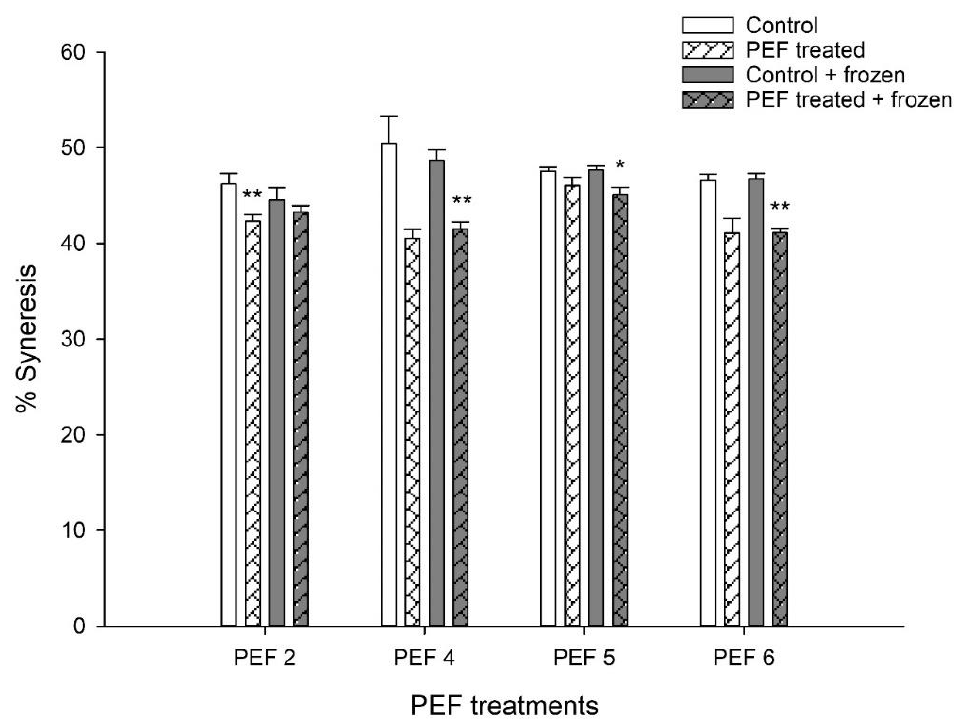
Figure 2. Effect of PEF pre-treatment of starter cultures on the syneresis of set yogurt. Yogurts were made with freshly PEF-pre-treated cultures (PEFx-D) or with cultures which were flash-frozen and stored at − 20 ◦ C for 14 days after PEF pre-treatment (PEFx-FF). PEF2, PEF4, PEF5 and PEF6 represent different PEF parameters. The bars indicate the mean values of three independent experiments ±1 standard deviation. * p < 0.1, ** p < 0.05 (paired t -test) compared with the respective controls (control vs. PEF-treated; control + frozen vs. PEF-treated + frozen).